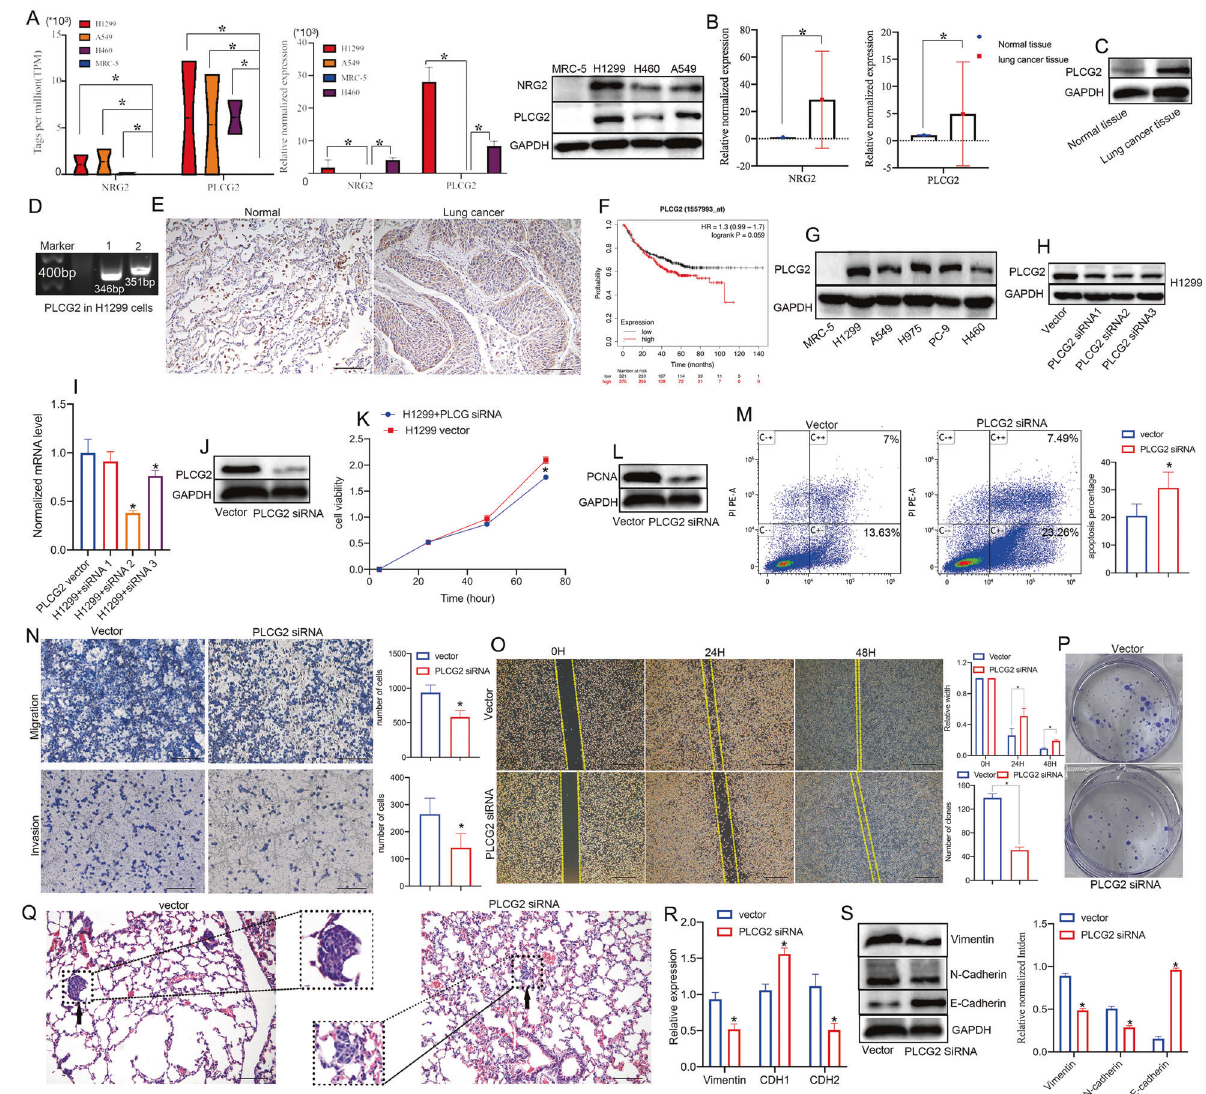
Fig. 4 The upregulated eccDNA-related gene PLCG2 promoted the proliferation, migration, and invasion of H1299 cells. A The abundance (the tags per million) and the expression of NRG2 and PLCG2 in NSCLC cells and MRC-5 cells detected by whole genome resequencing, qPCR and western blotting. B The mRNA expression of NRG2 and PLCG2 in lung cancer tissues and normal tissues by qPCR. C The protein level of PLCG2 in lung cancer tissues and normal tissues by western blotting. * P < 0.05. D The product of circle PLCG2 in H1299 cells by PCR. E IHC staining showing the level of PLCG2 in lung cancer tissues and normal tissues. F The relationship between PLCG2 and the recurrence-free survival of NSCLC patients in the TCGA database (Kaplan ‒ Meier Plotter, https://kmplot.com/analysis/index.php? p = service&start = 1). G Western blotting for PLCG2 levels of NSCLC cells and normal cells. H – J The knockdown ef fi ciency of PLCG2 in H1299 after PLCG2 siRNA transfection by qPCR and western blotting. K – M The proliferation ability, apoptosis rate and expression of proliferating cell nuclear antigen (PCNA) in H1299 after PLCG2 siRNA transfection. N – Q The migration and invasion of H1299 cells after PLCG2 siRNA transfection by transwell assay, wound healing assay, clonogenic assay and in vivo tail injection data. R , S The levels of EMT- related biomarkers in H1299 cells after PLCG2 siRNA transfection by qPCR and western blotting. * P <